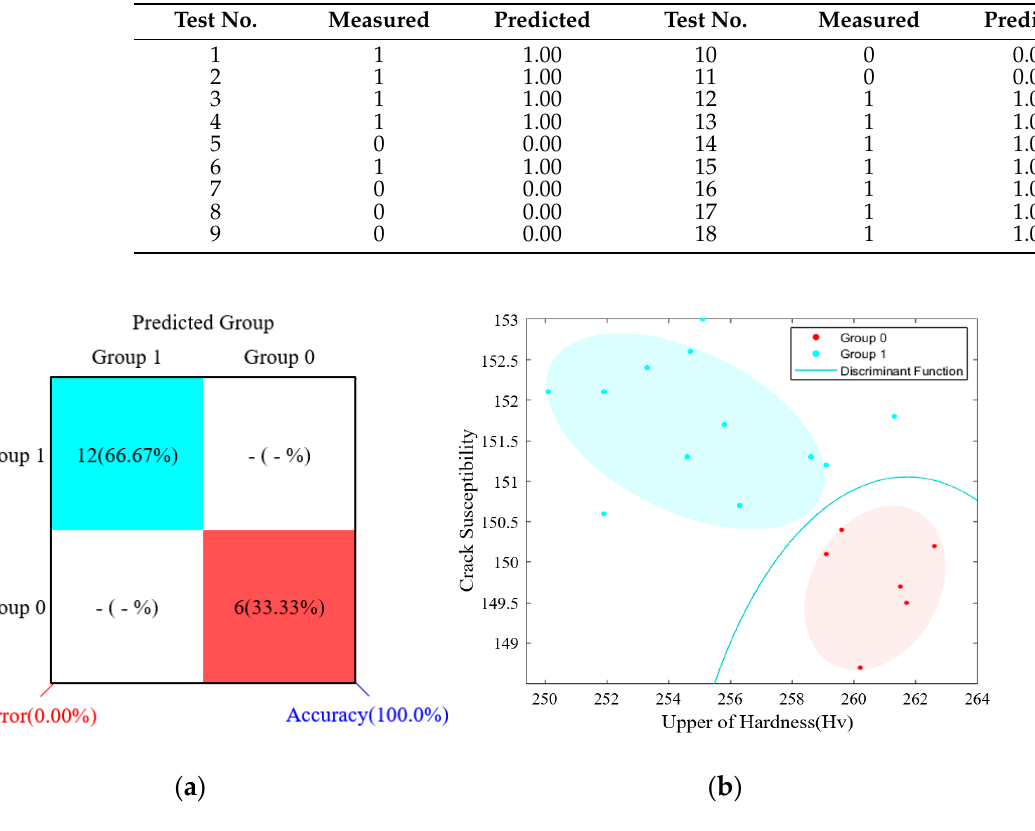
Figure 9. Performance of the discrimination model and discriminant function. ( a ) Performance of the discrimination model and ( b ) discriminant function.